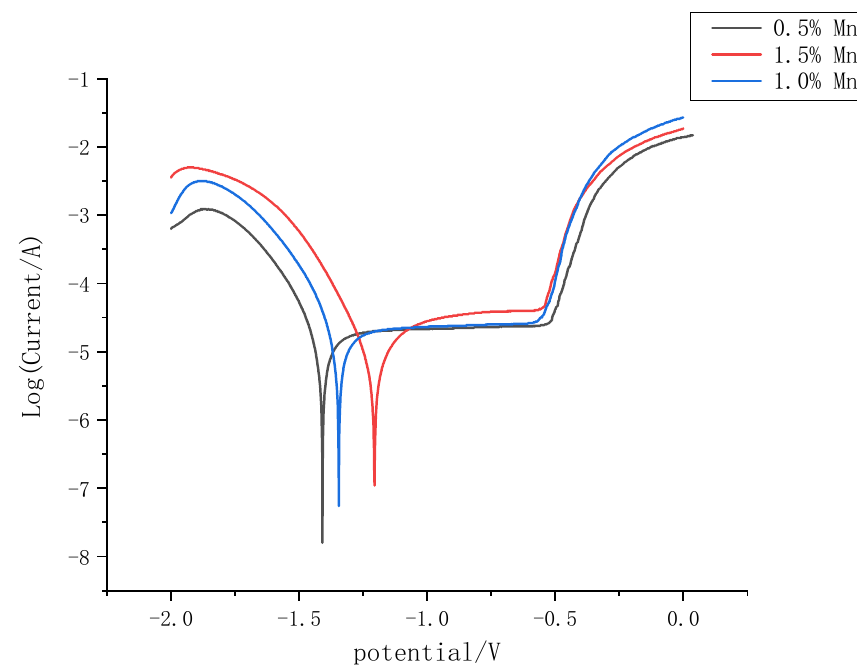
Figure 12. Potentiodynamic polarization curve of Mg-Mn-Zn alloy.